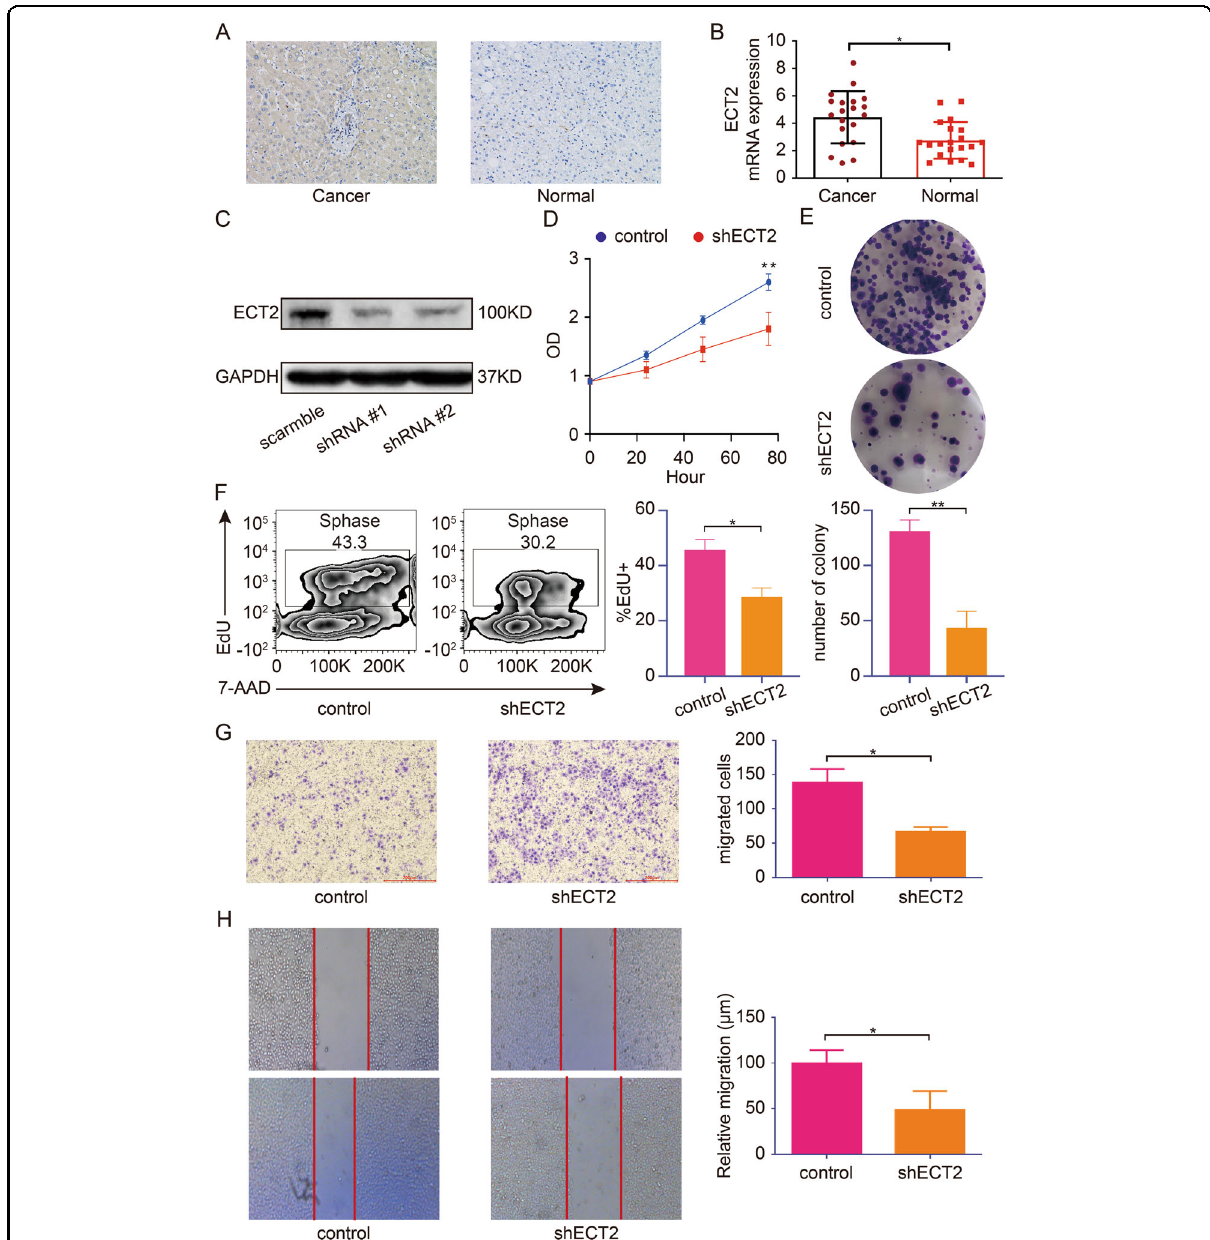
Fig. 3 Downregulation of ECT2 inhibits the proliferation and migration of HCC cells. A Representative immunohistochemistry stain of ECT2 in HCC and para-cancerous normal tissues. B Quanti fi cation of PCR analysis of ECT2 expression in HCC and para-cancerous normal tissues. C Western blot analysis of ECT2 after transfection of ECT2-targeting shRNA. D ECT2 downregulation inhibits cell proliferation. Cancer cells were transfected with ECT2-targeting shRNA, and the absorption (A450 nm) was detected at 0, 24, 48, and 72 h. E Cancer cells transfected with ECT2-targeting shRNA and the normal control were assayed for clonogenicity in adherent cultures. F EdU incorporation assay was used to examine the proliferation of cancer cells after ECT2 knockdown. G Transwell assay was used for cancer cells transfected with ECT2-targeting shRNA (magni fi cation 100×). H Wound- healing assay was used for cancer cells transfected with ECT2-targeting shRNA (magni fi cation 50×, scale bar: 500 μ m). Error bars represent means